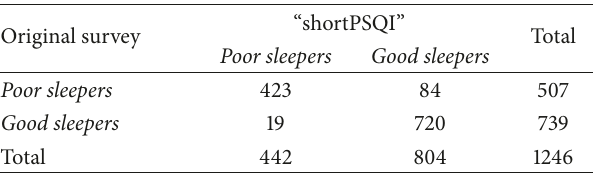
Kappa value 0.83 indicates an agreement (𝑝 < 0.001) between original and “shortPSQI,” based on a cut-off of 5 and 4 in PISQ and “shortPSQI,” respectively; McNemar’s test indicated a lack of agreement (𝑝 < 0.0001) or, rather, a lack of symmetry of false negative and false positive proportions. Based on the analyses, all global values greater than 4 in “shortPSQI” total score are detecting poor